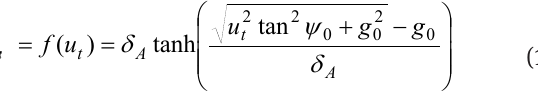
Figure 12: Simulation results for different normal loads ( σ displacement u : a) variations of shear stress, b) variations of dilatancy, c) asperity shape assumed for t